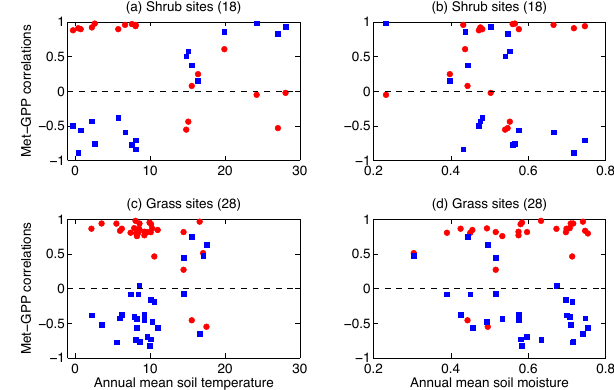
Figure 2. Correlations between monthly GPP and soil variables at (a, b) shrub and (c, d) grass sites. For each site, we calculate corre- lation coefficients of GPP–soil temperature (red points) and GPP– soil moisture (blue squares). These correlation coefficients are then plotted against the annual mean (a, c) soil temperature ( ◦ C) or (b, d) soil moisture (fraction) at each